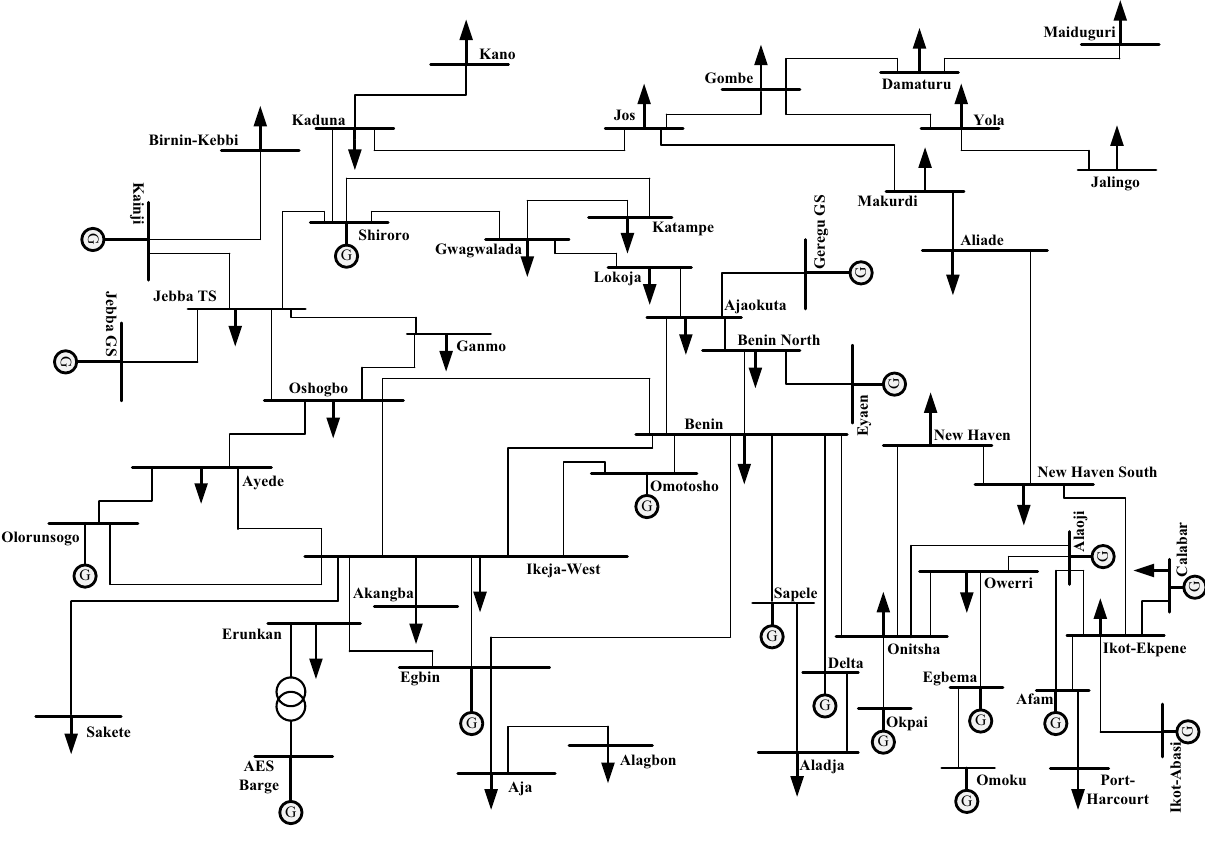
Figure 1. One-line diagram of 52-bus, 330 kV Nigerian power